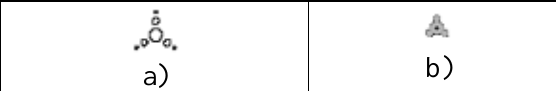
6. Informatyvumas . Sutartinis ženklas turi teikti kiek